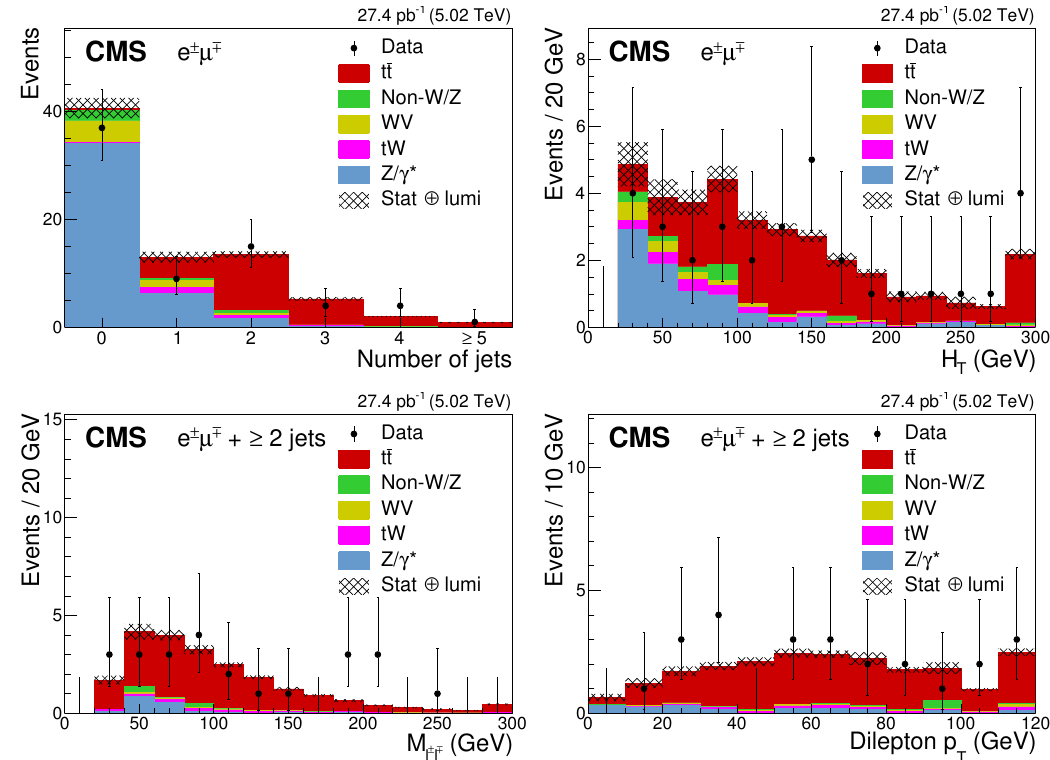
Figure 3 . Predicted and observed distributions of the (upper row) jet multiplicity and scalar p T sum of all jets ( H T ) for events passing the dilepton criteria, and of the (lower row) invariant mass and p T of the lepton pair after requiring at least two jets, in the e (cid:6) (cid:22) (cid:7) channel. The Z/ (cid:13) (cid:3) and non- W/Z backgrounds are determined from data (see section 6.2). The cross-hatched band represents the statistical and integrated luminosity uncertainties in the expected signal and background yields added in quadrature. The vertical bars on the data points represent the statistical uncertainties. The last bin of the distributions contains the over(cid:13)ow events.